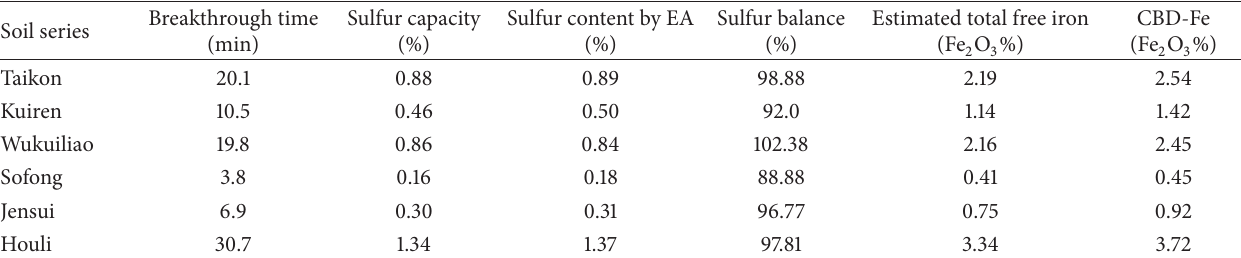
Table 4: The sulfur capacities and estimated total free iron of six representative soil samples at 773 K under the experimental condition of 50% H 2 .